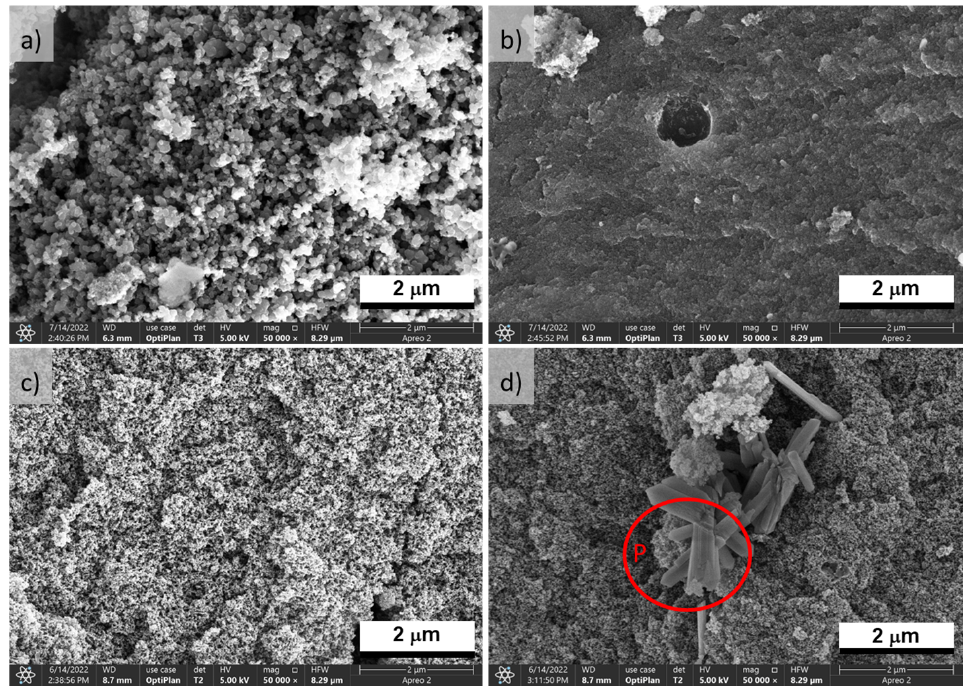
Figure 2. SEM micrographs at ×50,000 of BNCA-Pat 500 °C ( a , b ) and at 600 °C ( c , d ). P area: clusters of phosphorus particles.